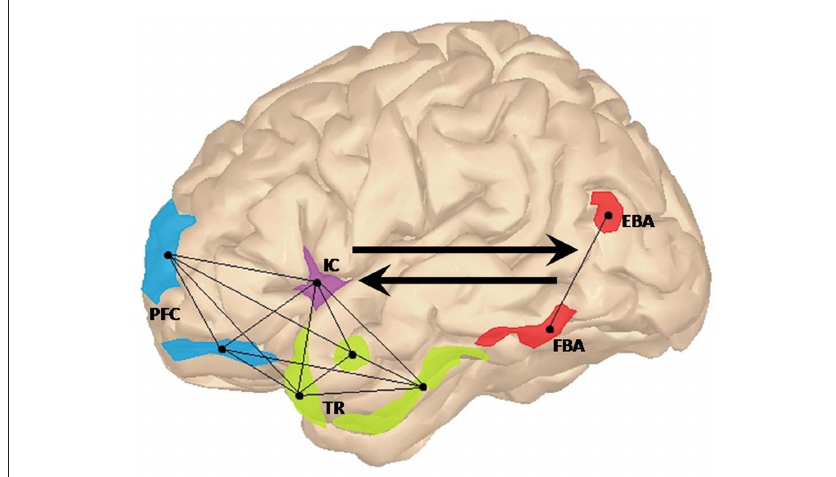
Figure 1 | Lateral view of the left hemisphere showing the proposed fronto-insular–temporal network (light-blue, violet, and green regions of interest, respectively). In this context network, prefrontal areas (PFC) such as frontopolar and dorsolateral prefrontal cortices would be involved in the generation of focused predictions via the update of associative activation of representations in the specific context. The insular cortex (IC) would provide the convergence point for emotional and cognitive states related to the coordination between external and internal milieus, facilitating the fronto-temporal interaction in social context processing. Finally, target-context associations stored in the temporal regions (TR) would be integrated with feature-based information processed in frontal regions. EBA and FBA (colored in red), would contribute to this larger network by making explicit lower-level perceptual information regarding body posture and body shape. Connected nodes represent the fronto-insular–temporal interactions. Black arrows show the top-down contextual modulation of activations in EBA and FBA and the bottom-up contribution of these later regions to